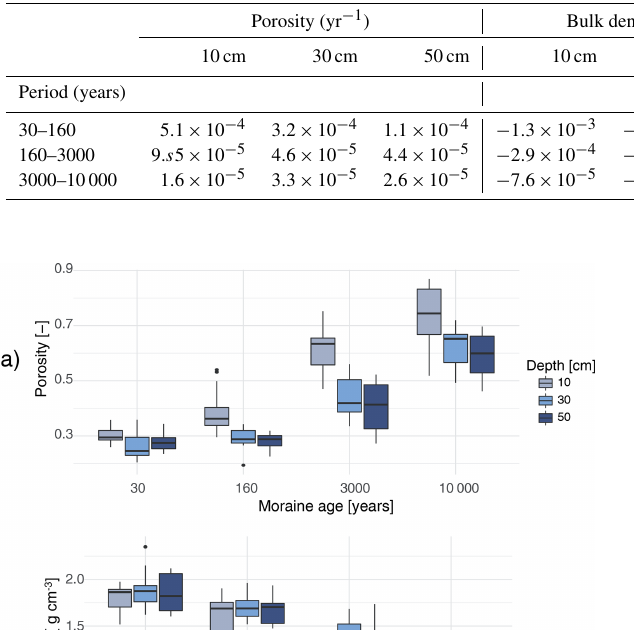
Table 1. Linear rates of change in porosity, bulk density, and grain size between adjacent age classes calculated based on median values. Mass fraction: mf%.